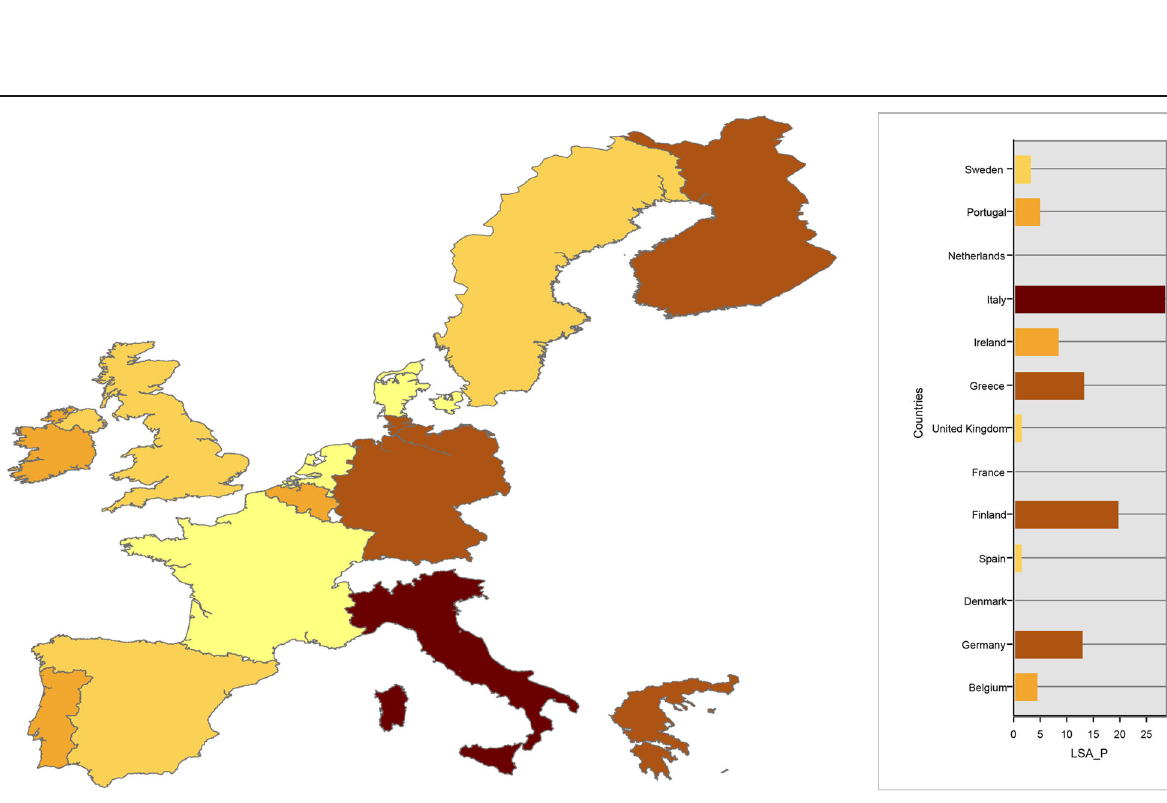
Fig. 14 Detainable remarks percentage for LSA Code for EU15